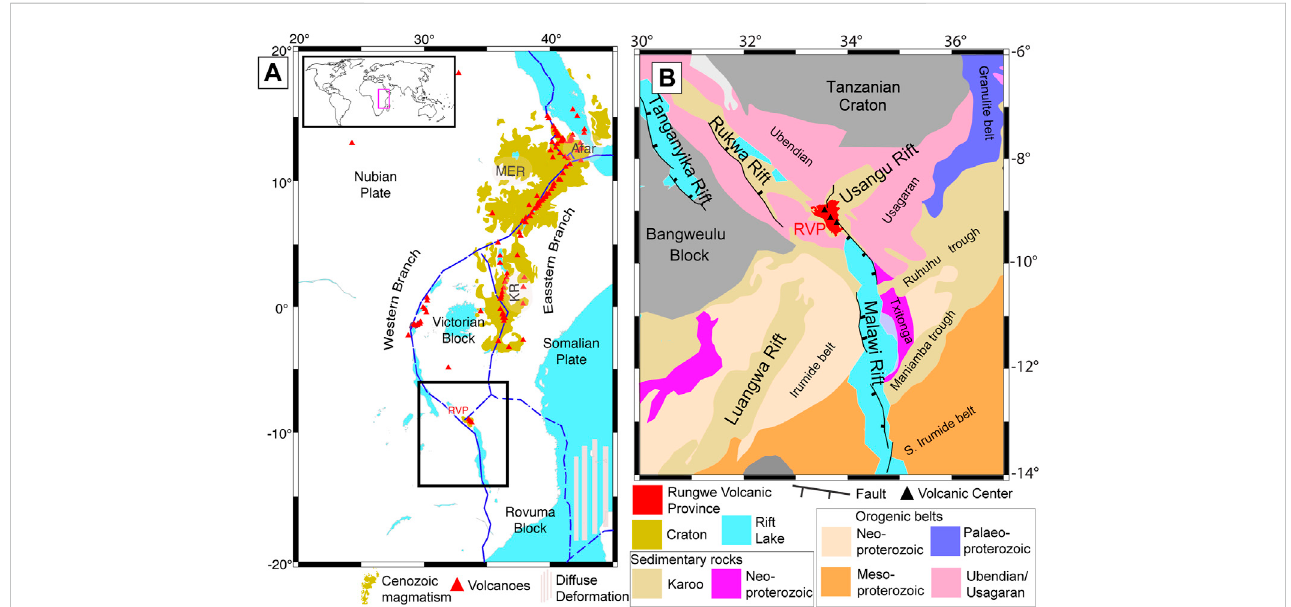
FIGURE 1 (A) .MapoftheEastAfricanRift(EAR)showingtheEasternandWesternBranches.TheWesternBranchoftheEARhasfewervolcaniccenters(redtriangles areHolocenevolcanoes)thantheEasternBranch.TheHolocenevolcanoesarefromtheSmithsonianGlobalVolcanismProgram(GlobalVolcanismProgram, 2013). The Cenozoic volcanic rocks (yellow) are outlined after Thiéblemont et al., 2016 and indicate the large igneous province (LIP) in East Africa. RVP = RungweVolcanicProvince.KR=KenyanRift.MER=MainEthiopianRift.TheblackrectangleshowsthelocationofFigure1B.Dashedbluelinesrepresent plate boundaries from Stamps et al. (2008). The inset map shows the relative location of part of the EAR (pink rectangle) on Earth. The diffuse deformation offshoreoftheEasternBranchisbasedongeodeticstudybyStampsetal.(2021). (B) .Mapofmajorterranesandgeologicalfeaturesinthesouthernpartofthe Western Branch of the EAR that are based on Fritz et al. (2013). The major rift faults are extracted from Muirhead et al. (2019). Black triangles from north to south represent the three large active volcanoes (Ngozi, Rungwe and Kyejo; Harkin, 1962; Fontijn et al., 2010) of the